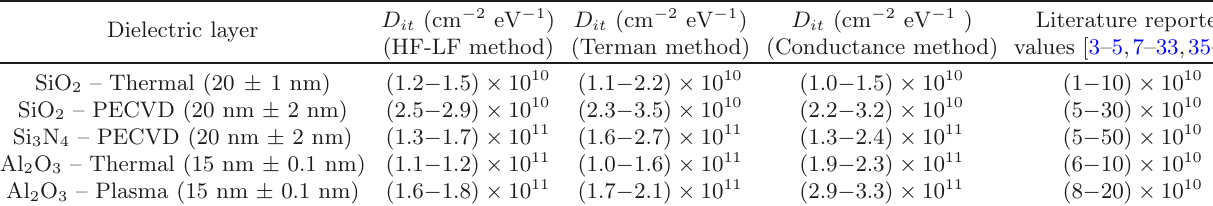
Table 2. Extracted interface state density ( D it ) from C - V measurements.